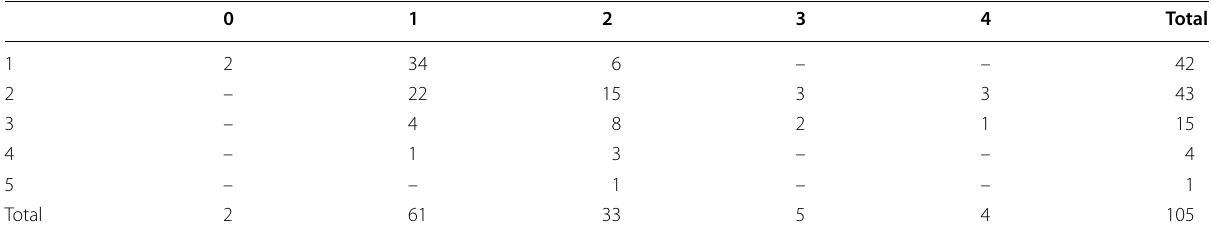
Table 5 Variation of number of hypothesized differential diagnosis showed by coupling the figure before and after ultra- sound scan (in the first coloumn the number of diagnosis before the